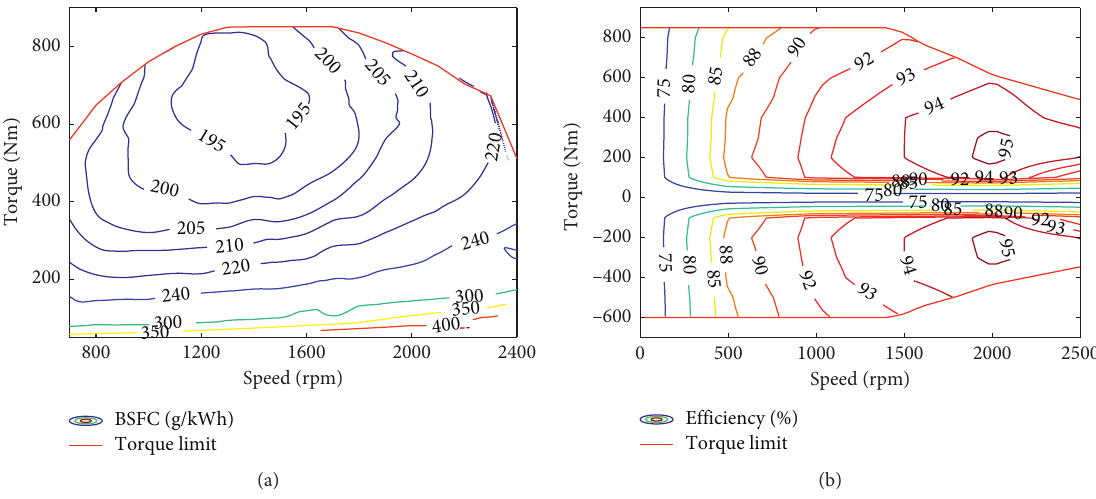
Figure 21: Characteristic diagrams. (a) Engine. (b) Motor.